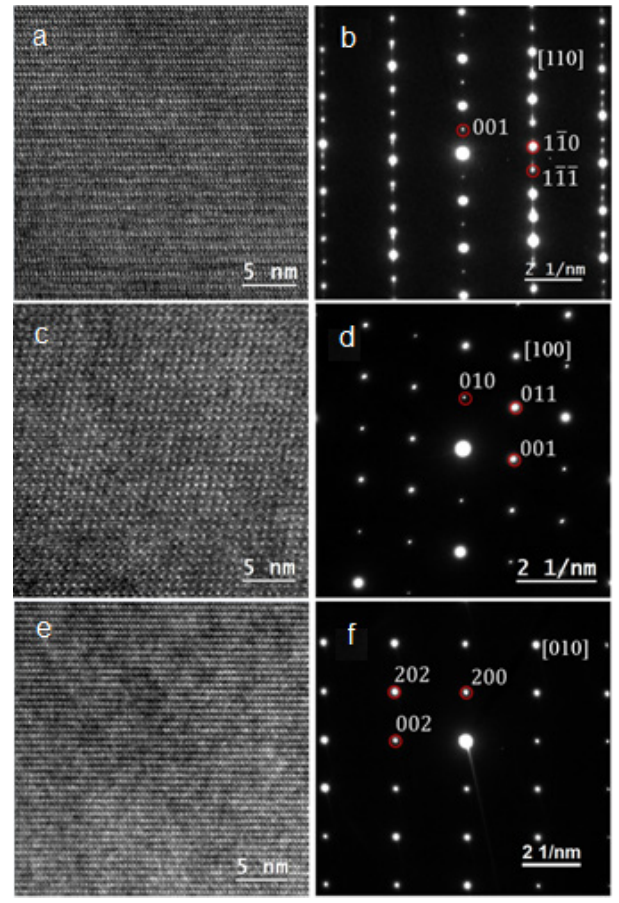
Figure 4. High-resolution TEM images ( a , c and e ) and corresponding selected area diffraction patterns ( b , d and f ) obtained from areas A, B and C in Figure 2, respectively. With the help of single crystal diffraction simulations and indexing (red circles), the structures of areas A, B and C are identified as Zr 2 Ni 7 , Zr 8 Ni 21 and Zr 7 Ni 10 ,